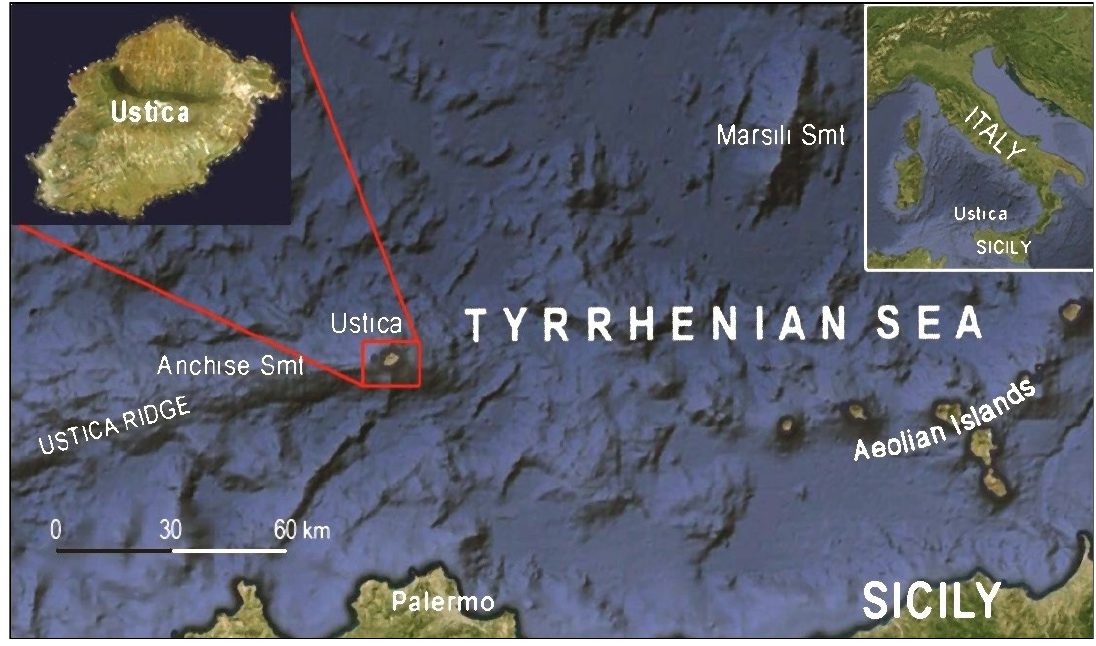
Figure 2. Ustica in the Tyrrhenian Sea (modified from Google